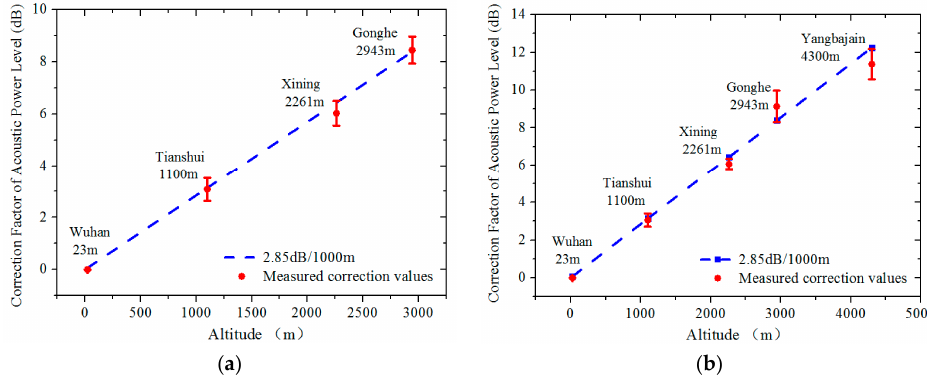
Figure 8. Comparison of test results and calculated results. ( a ) Average values during 16–18 kV/cm; ( b ) average values during 15–16 kV/cm.